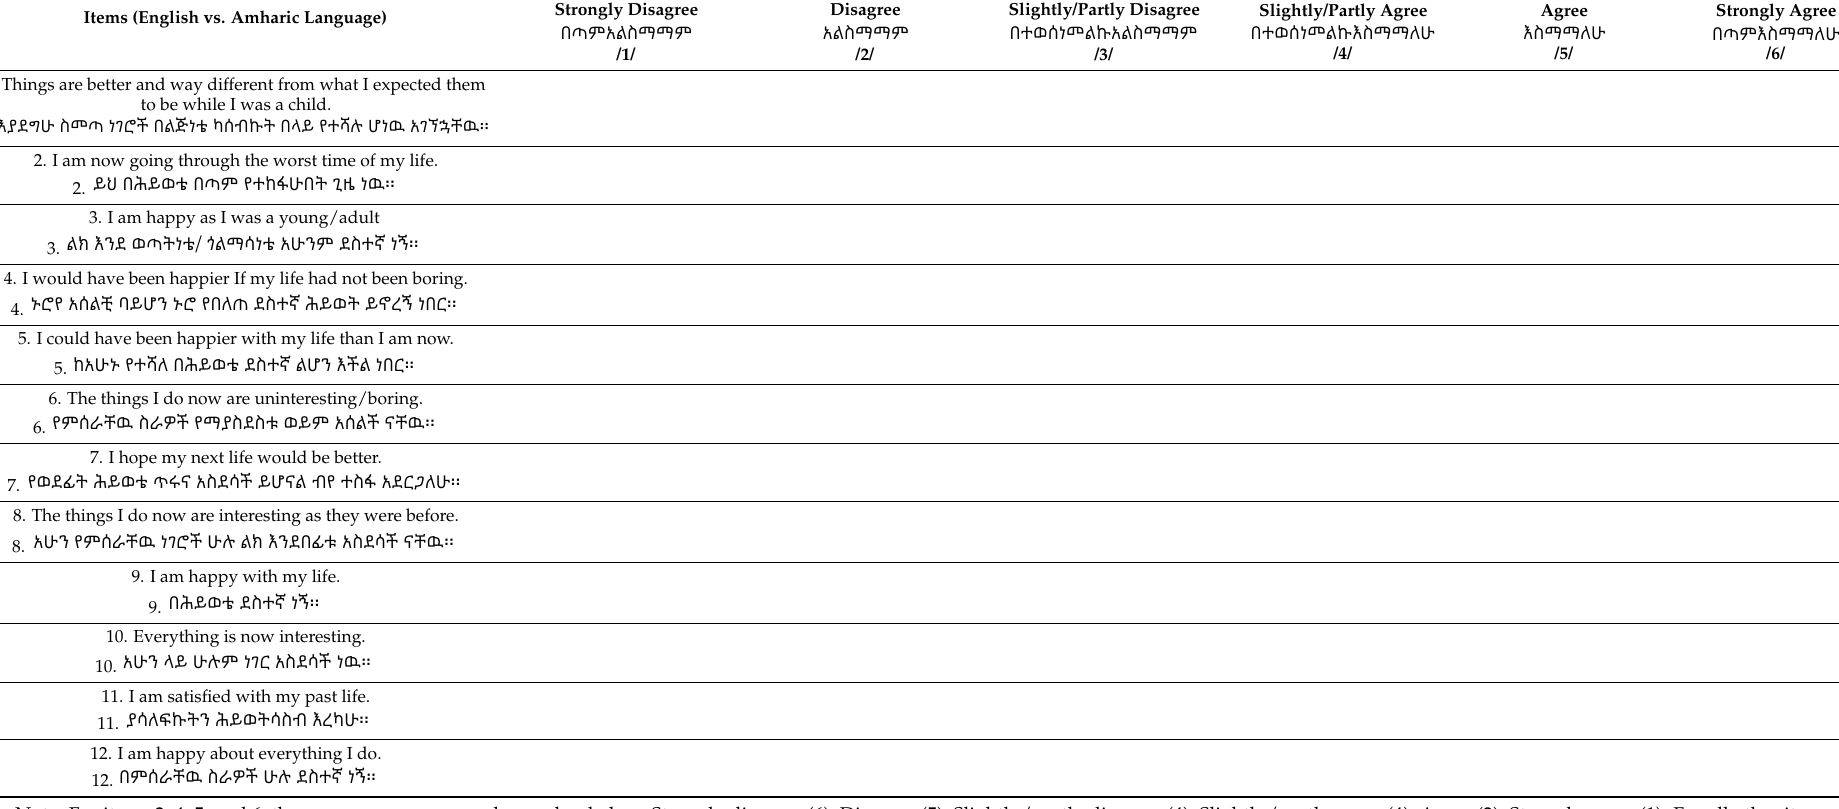
Table A1. The validated and psychometric tested the Amharic version of the Life Satisfaction Index for the Third Age—Short Form (LSITA-SF12). Items (English vs. Amharic Language)